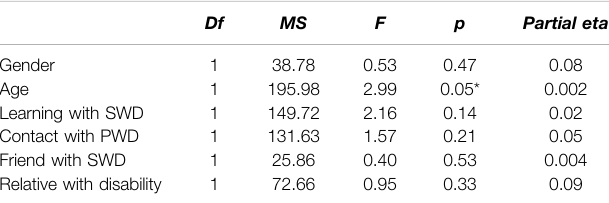
TABLE 3 | Effect of knowledge on demographics and